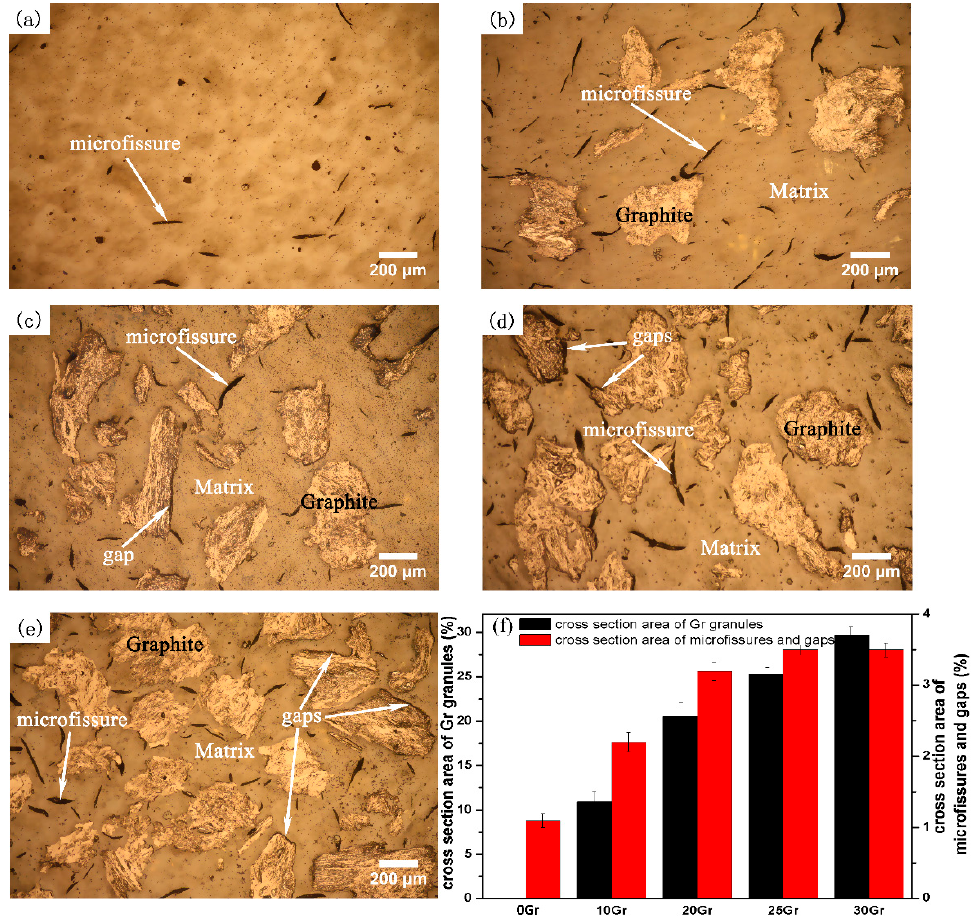
Figure 1. Microstructures of investigated specimens before test: ( a ) graphite (Gr)-free phenolic resin (PF) matrix; ( b ) 10 vol.% Gr/PF; ( c ) 20 vol.% Gr/PF; ( d ) 25 vol.% Gr/PF; ( e ) 30 vol.% Gr/PF, ( f ) column diagram of Gr granules, micro-fissures and gaps’ cross section area.